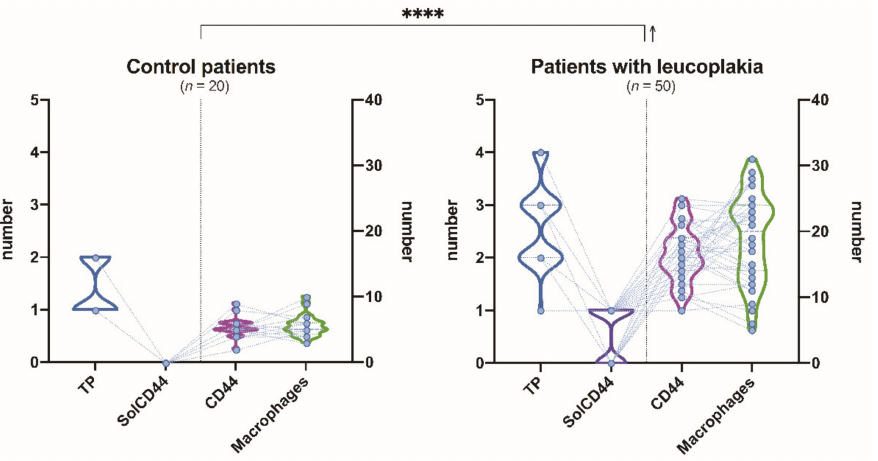
Figure 4. Comparison of paired associations of total protein, SolCD44, mean number of CD44 expressed in epithelial layers in leukoplakia tissue, and macrophages in lamina propria between control group and patients with leukoplakia. **** p < 0.0001 (repeated-measures two-way ANOVA with two-stage linear step-up procedure of Benjamini, Krieger, and Yekutieli as post hoc procedure) indicates the level of statistical significance of between-group difference, regarding the analyzed parameters. The arrow indicates an increase in the average values of the corresponding group compared to the control.